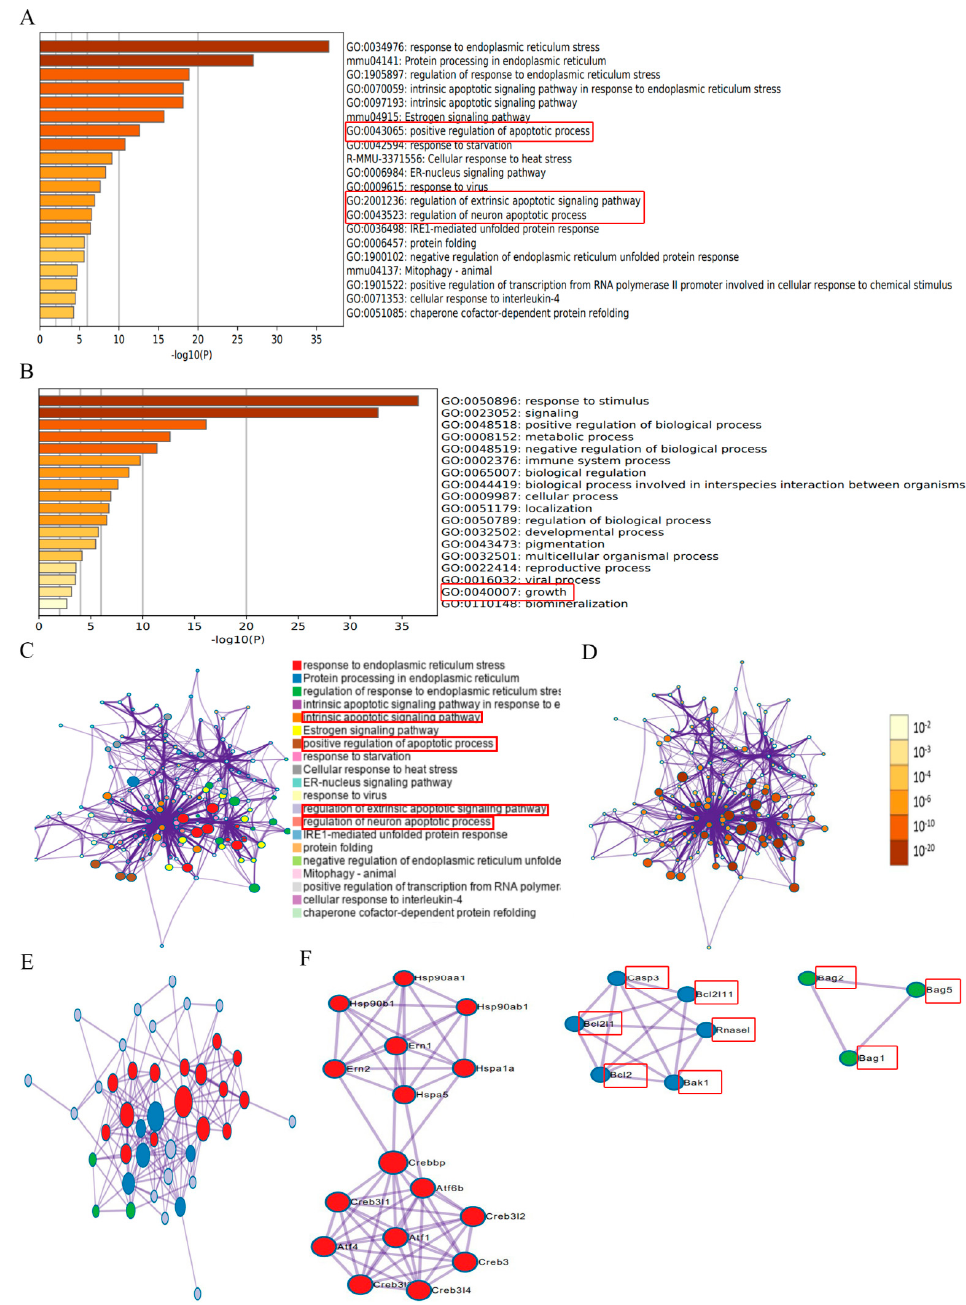
Figure 2. Identification of endoplasmic reticulum (ER) stress regulators via Metascape online analysis. ( A ) Bar graph of enriched terms across ER stress gene lists; colors indicate p -values. ( B ) The top-level Gene Ontology biological processes are shown. ( C ) Network of enriched terms: color-coded by cluster ID, where nodes that share the same cluster ID are typically close to each other. ( D ) Network colored-coded by p -value, where terms containing more genes tend to have a more significant p - value. ( E , F ) Protein–protein interaction network and MCODE components identified in the ER stress gene